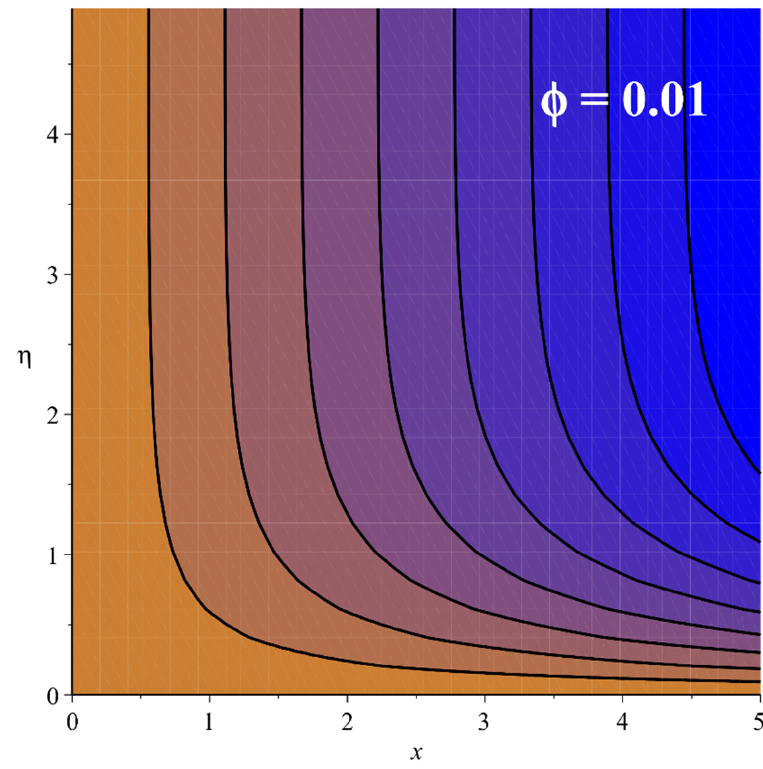
Figure 16. Stream lines when φ = 0.01